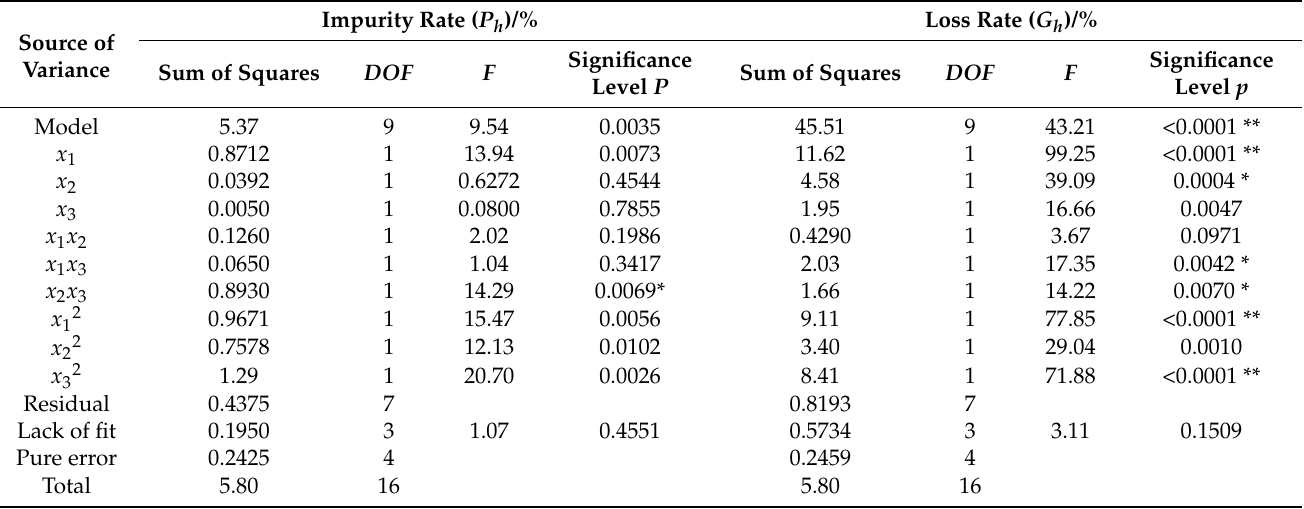
Table 6. Variance analysis of regression model.